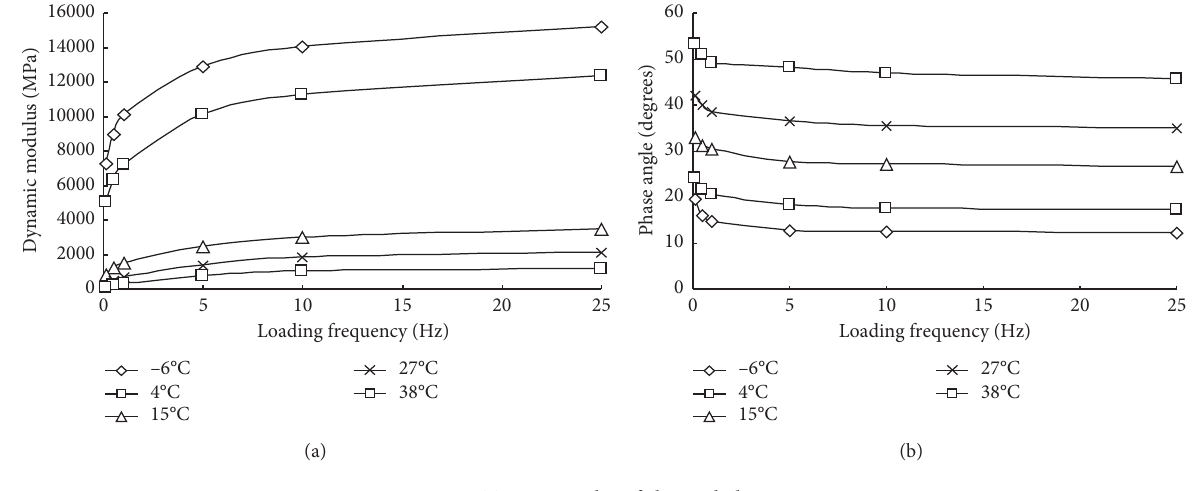
Figure 5: Testing results of the asphalt mastic. Table 2: Parameters of the numerical samples using the B-model.